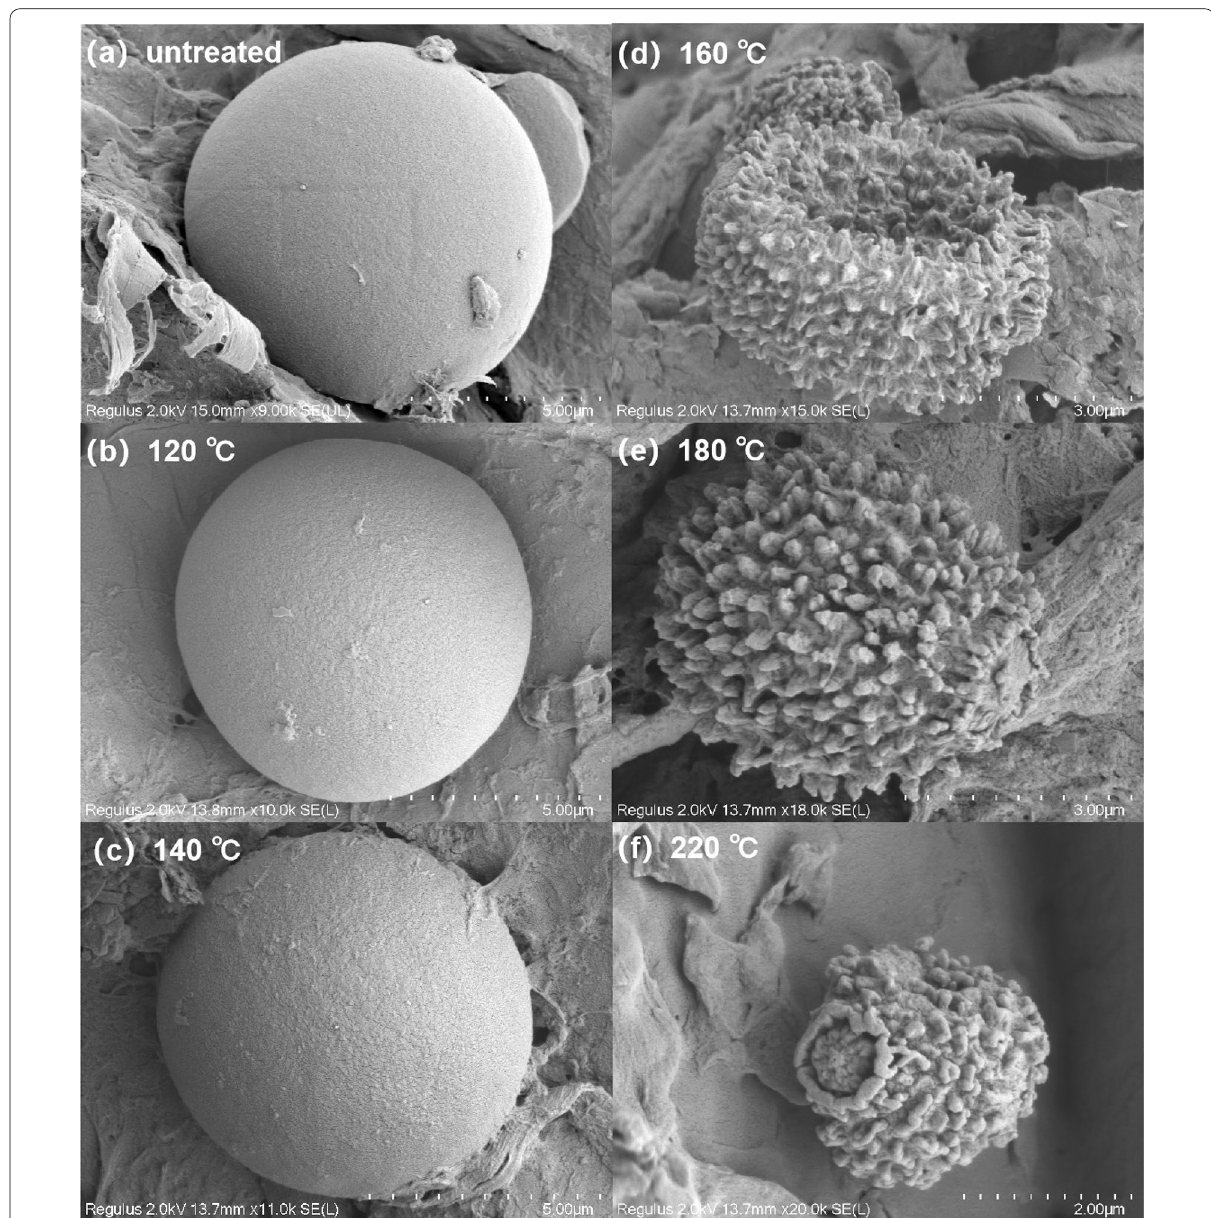
Fig. 5 SEM images of starch granules in the untreated- and treated parenchyma